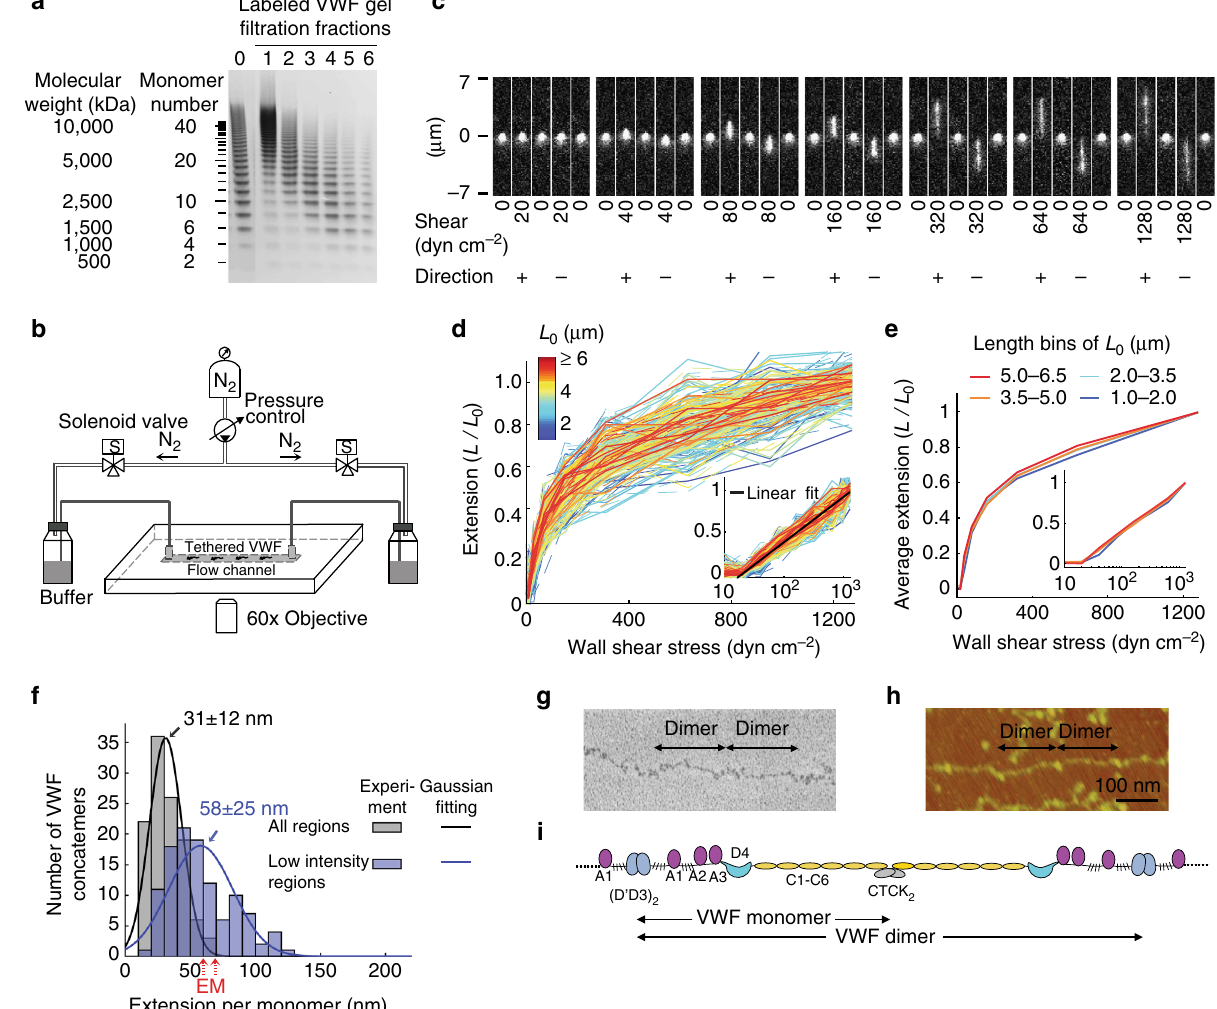
Fig. 1 VWF elongation under fl ow. a VWF concatemer size analysis by SDS- 1% agarose gel electrophoresis. Lanes are without (0) or with Sepharose CL-2B gel fi ltration (1 – 6). b Schematic of the TIRF microscope with pressure-actuated fl ow. c Representative VWF molecule under cycles of start- and stop- fl ow in forward (+) and backward ( − ) directions at indicated wall shear stresses (10 ms exposure every second). d VWF concatemer extension ( N = 112 concatemers) normalized to length at 1280 dyn cm − 2 ( L 0 , color key) vs. wall shear stress under forward ( solid lines ) and backward ( dash lines ) fl ow (Supplementary Fig. 1 a, b). Inset shows the linear fi t to log of shear stress. e Average VWF concatemer extension in d for the four L 0 bins. f Average extension of VWF monomers for all regions or only the low intensity regions (Supplementary Fig. 2) of VWF concatemers in d . Red arrows : VWF monomer contour length measured by EM 24, 25 . g , h EM 24 and AFM 26 images of VWF concatemers. i VWF concatemer schematic